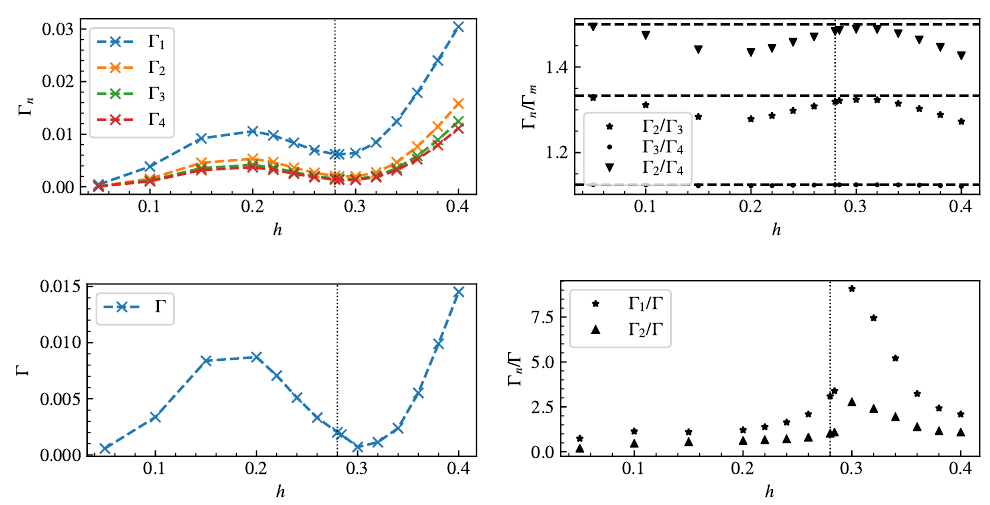
Figure B.5: Left panels: Entropy growth rates Γ (top) and magnetisation relaxation n rate Γ (bottom) in units J = 1 for longitudinal quenches in the quantum Potts spin chain starting from g = 1.5 as a function of the longitudinal coupling. Right: Ratios Γ / Γ / Γ (bottom). The dashed lines represent the universal ratios (4.4) (top) and Γ n m n that are restored in the limit h → 0. The vertical line is drawn at the value h where crit the second quasi-particle appears in the post-quench spectrum.